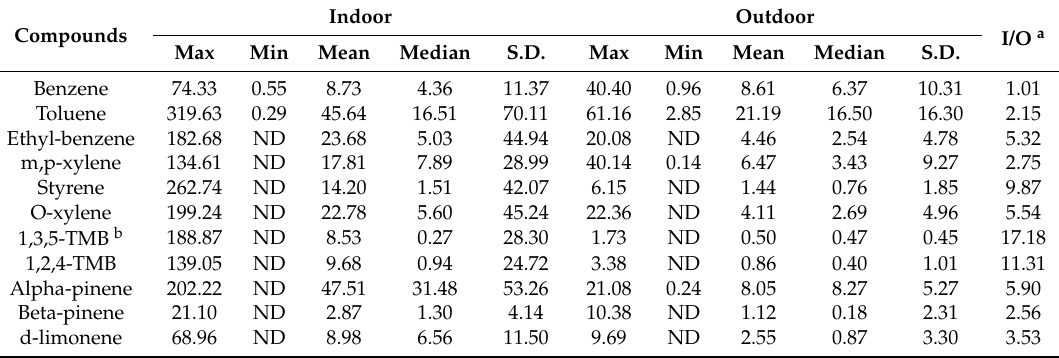
Table 3. The main compounds of VOCs in the indoor and outdoor air of hot spring hotels, µ g ¨ m ´ 3 . Indoor Compounds